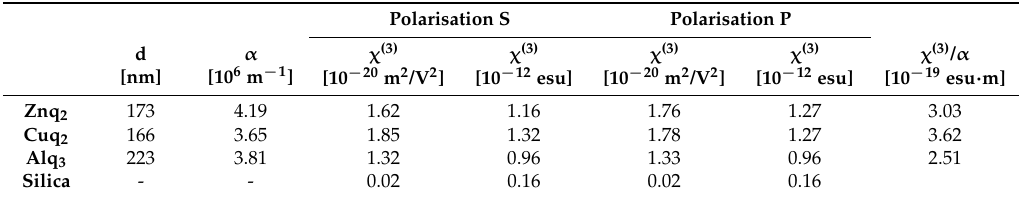
Table 1. The values of the third order nonlinear optical susceptibility χ the third harmonic generation (THG) technique for polarization s and p.